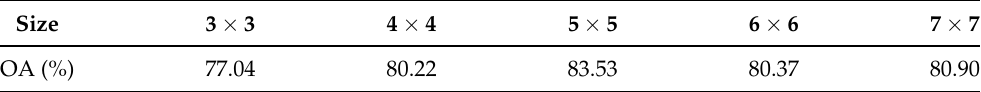
Table 2. Extraction accuracies of the RMS when using windows with different